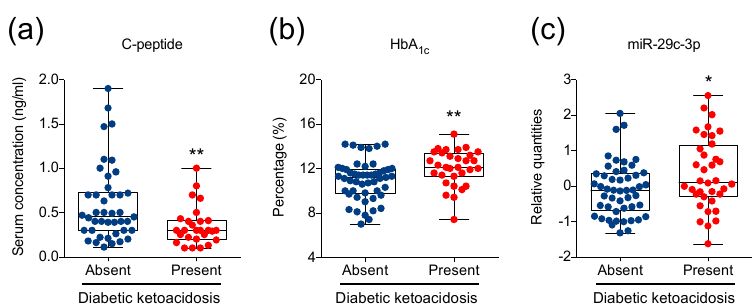
Figure 4. Significantly higher levels of plasmatic miR-29c-3p in the presence of diabetic ketoacidosis (DKA). ( a , b ) Whisker plots showing serum concentration of C-peptide ( a ), percentage of HbA1c ( b ), and relative quantities of plasmatic miR-29c-3p ( c ) in recent onset T1D children who presented or did not present DKA, as indicated. Mann-Whitney tests were performed: * p < 0.05, ** p < 0.01. Numbers of children with no DKA = 42 ( a ), 50 ( b ), and 49 ( c ). Numbers of children with DKA = 27 ( a ), 31 ( b ), and 36 ( c ).